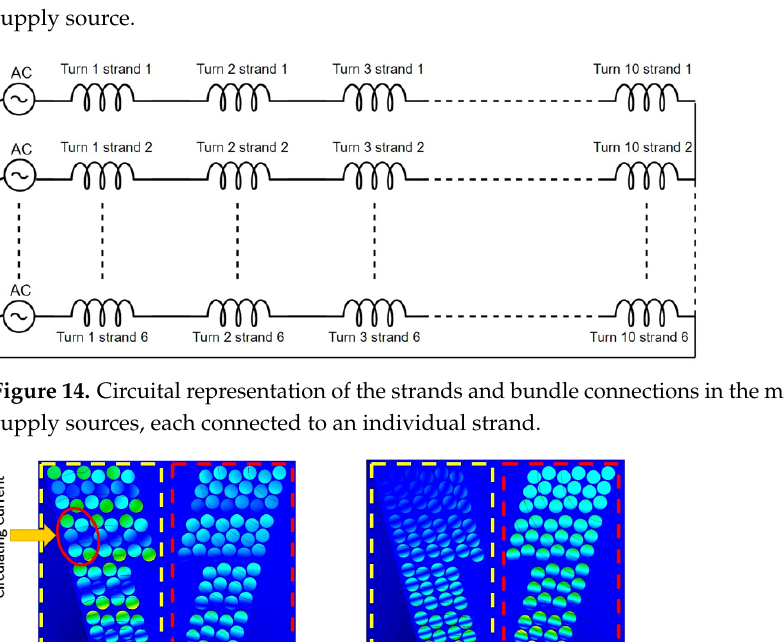
Figure 13. Circuital representation of the strands and bundle connections in the models with a single supply source.